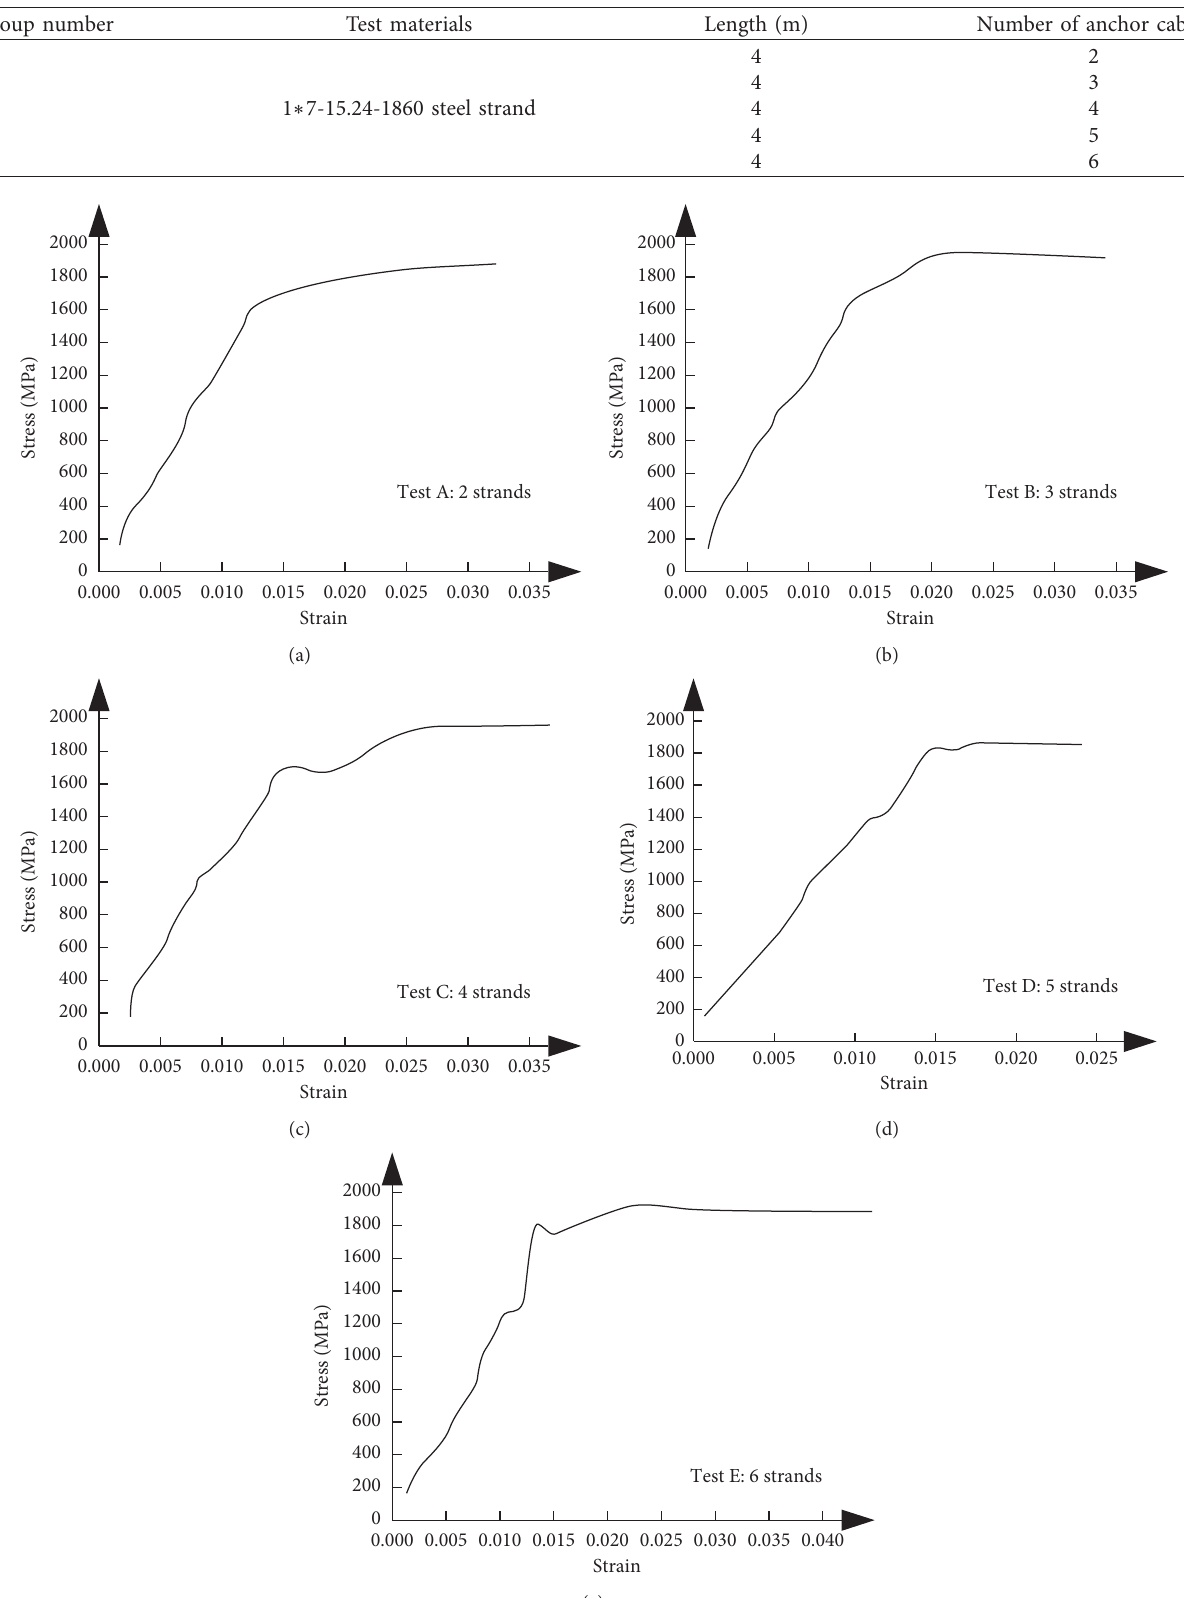
Table 1: Quantitative effect test scheme for mechanical properties of anchor cable bundles.